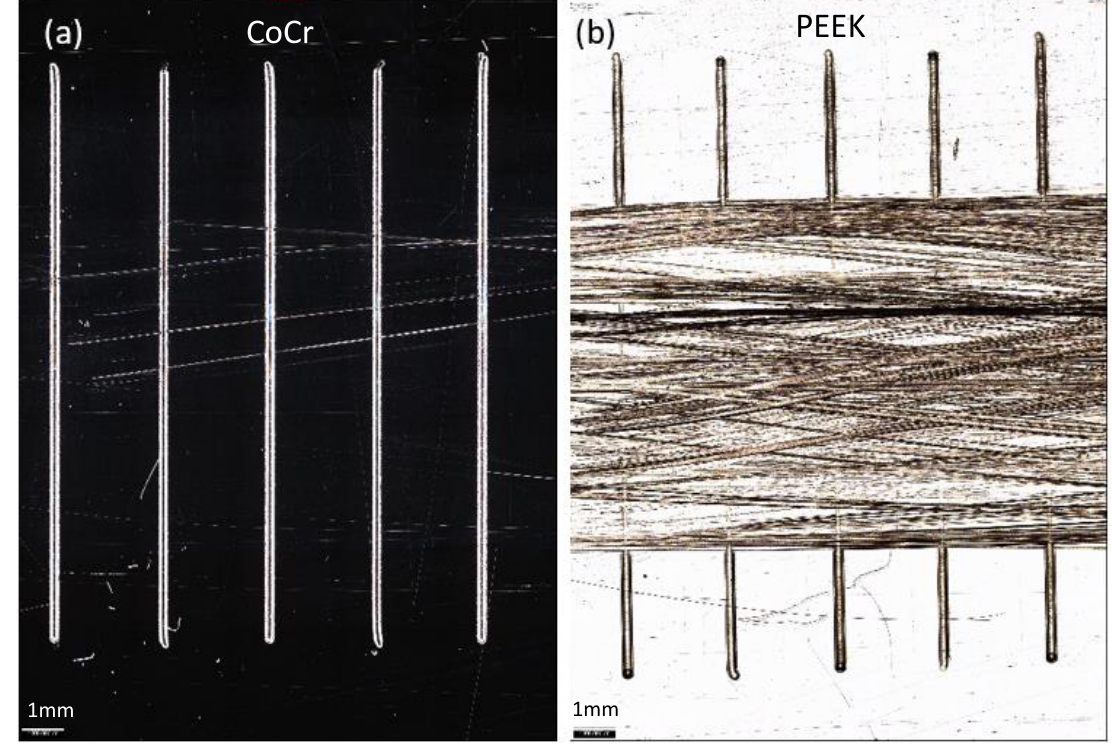
Figure 6. Representative images of CoCr ( a ) and PEEK ( b ) plates taken using an Alicona G5 IF with 5 × magnification. The plates were scratched with a diamond stylus to create a scratch lip height of 4 µm, then 1 million cycles (MC) wear simulation was carried out perpendicular to the direction of the scratches. Scale bar represents 1 mm.